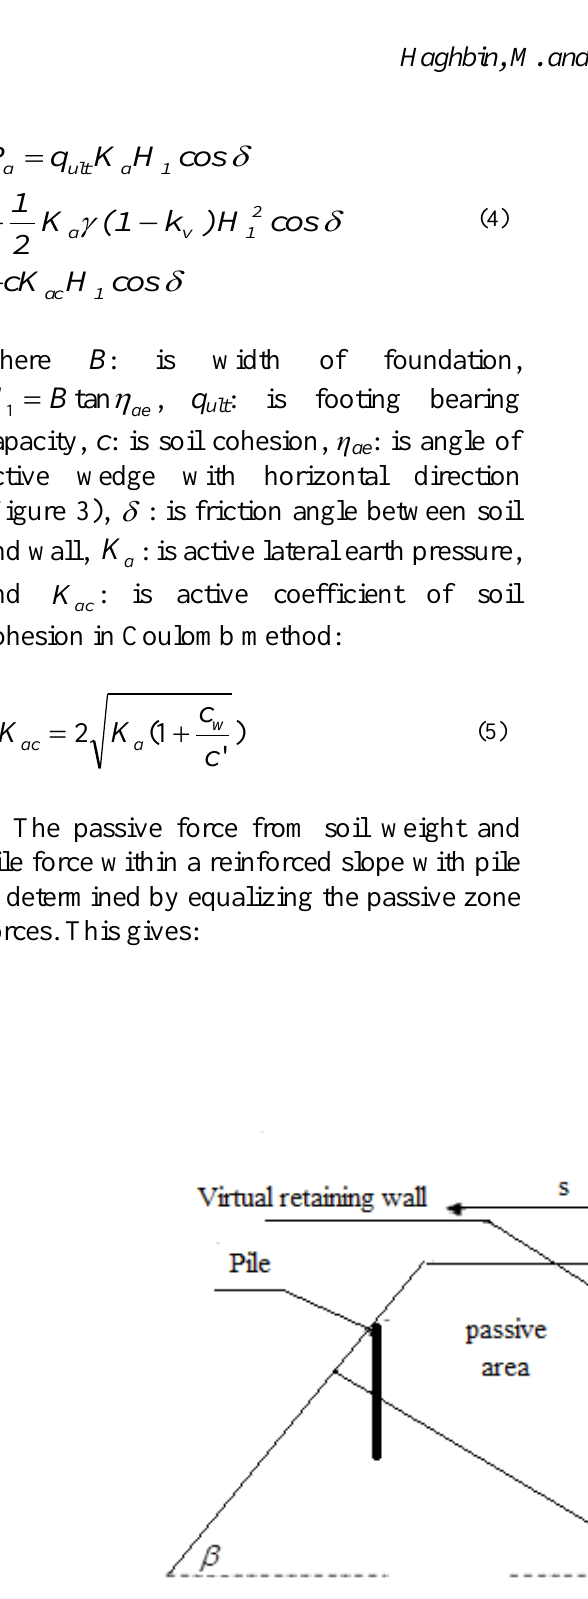
Fig. 3. Failure mechanism of soil beneath footing (virtual retaining wall